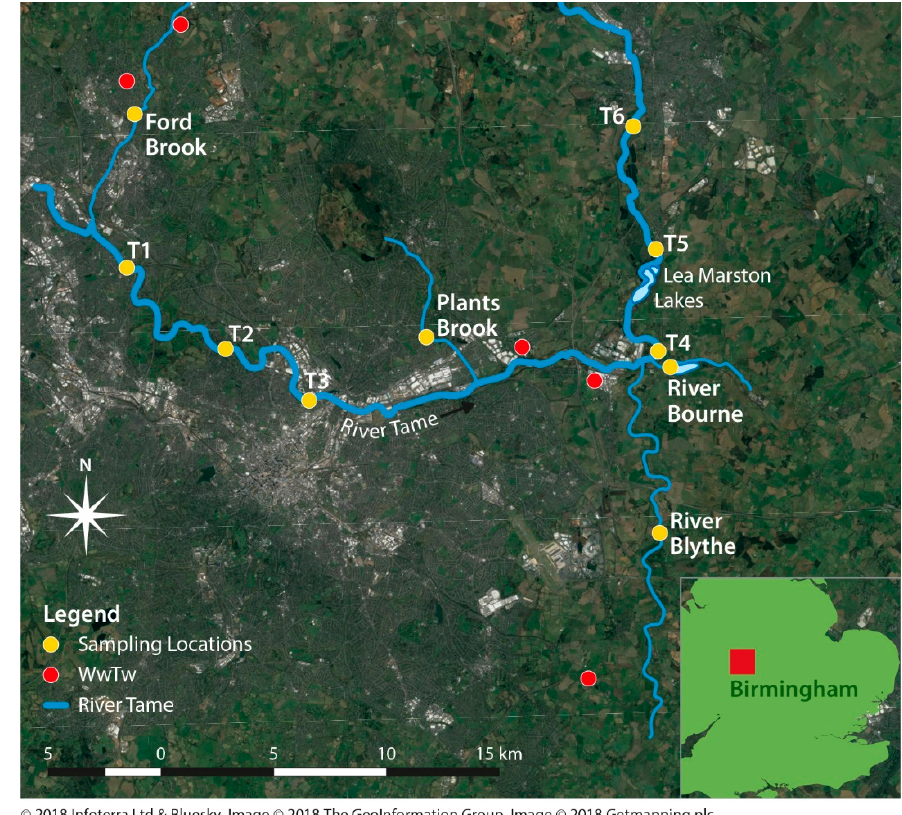
Figure 1. Study site map indicating location of study sites along the River Tame in Birmingham (labelled T1–T6). Also shown are additional sampling sites on tributaries of the River Tame and locations of wastewater treatment works (WwTw).